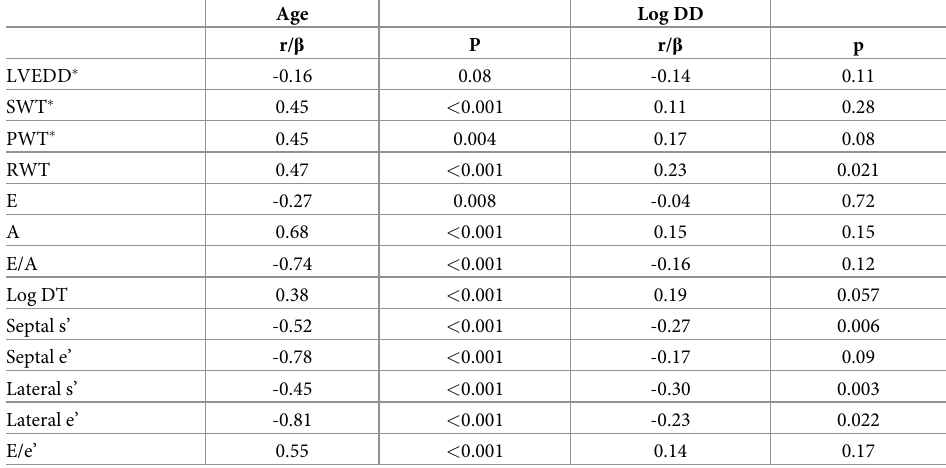
Table 3. Correlations of age and disease duration with left ventricular structural, transmitral Doppler and left ventricular long-axis function variables in subjects with systemic sclerosis.